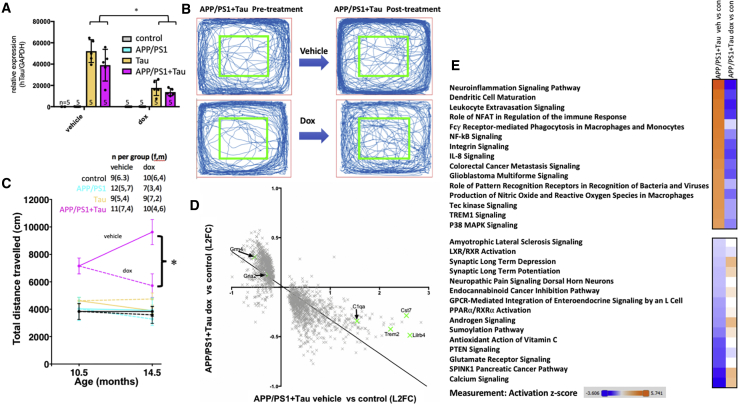
Lowering Tau Levels Ameliorates Hyperactivity Phenotype and Transcriptional Changes(A) Transgene suppression (dox) reduced human tau mRNA levels by approximately 65% as measured by qPCR (∗two-way ANOVA, effect of treatment F[1,31] = 42.22, p < 0.0001).(B and C) Representative traces of open-field activity from a APP/PS1+Tau mouse treated with vehicle and one treated with doxycycline, and the trace from the same mice after treatment (B), show clear amelioration of hyperactivity phenotype in one mouse, which is confirmed by quantification of distance traveled (C, repeated-measures ANOVA, effect of genotype F[3,69] = 34.12, p < 0.0001; effect of treatment F[1,69] = 6.75, p = 0.01; interaction F[3,69] = 6.13, p = 0.001; ∗Tukey’s multiple comparison tests, dox-treated APP/PS1+Tau mice are significantly different from vehicle-treated APP/PS1+Tau mice at 14.5 months of age, p < 0.0001).(D) RNA-seq data show that dox treatment to reduce tau levels reverses transcriptional changes in APP/PS1+Tau mice (linear regression slope = −0.34, 95% CI −0.36 to −0.33). Each point represents a single transcript (average of n = 5 mice per group).(E) Pathway analysis reveals that the top 15 up- and downregulated canonical pathways in APP/PS1+Tau mice compared with controls recover to normal levels or past normal levels with dox treatment (orange indicates increases, and blue indicates decreases compared with control levels; analysis from Ingenuity Pathway Analysis software).Biological replicate/experimental unit for each experiment is an individual mouse, n per group shown in (A) and (C). See also Figures S3 and S4 and Tables S1, S2, and S3.